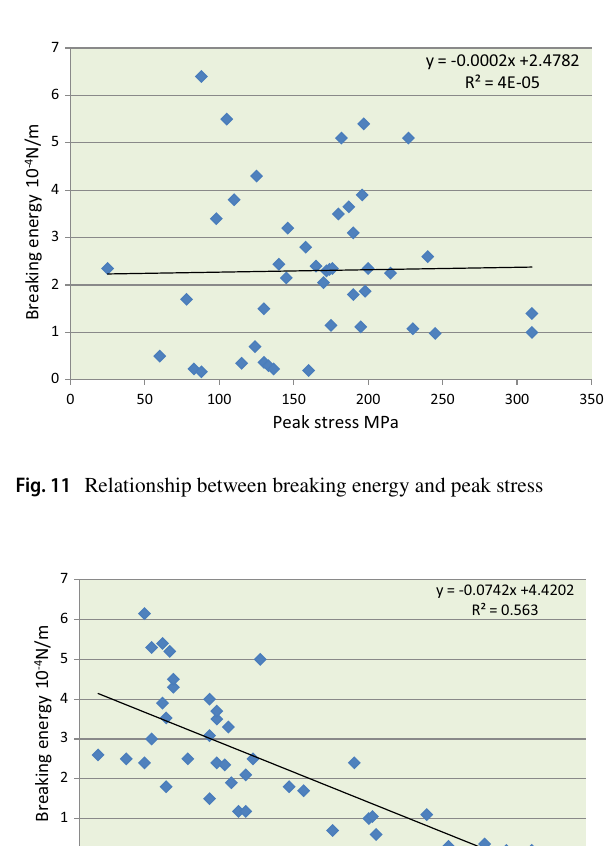
Fig. 10 Relationship between breaking energy and peak strain